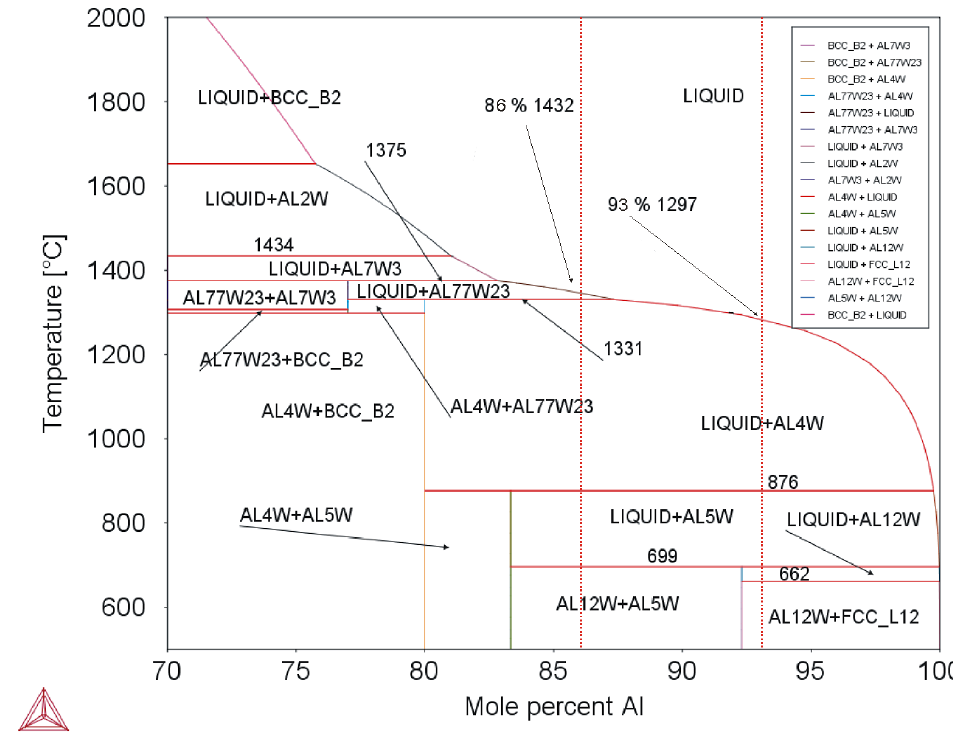
Figure 12. Binary diagram of W – Al system (Thermo-Calc; dotted red lines mark composition of analysed alloys).